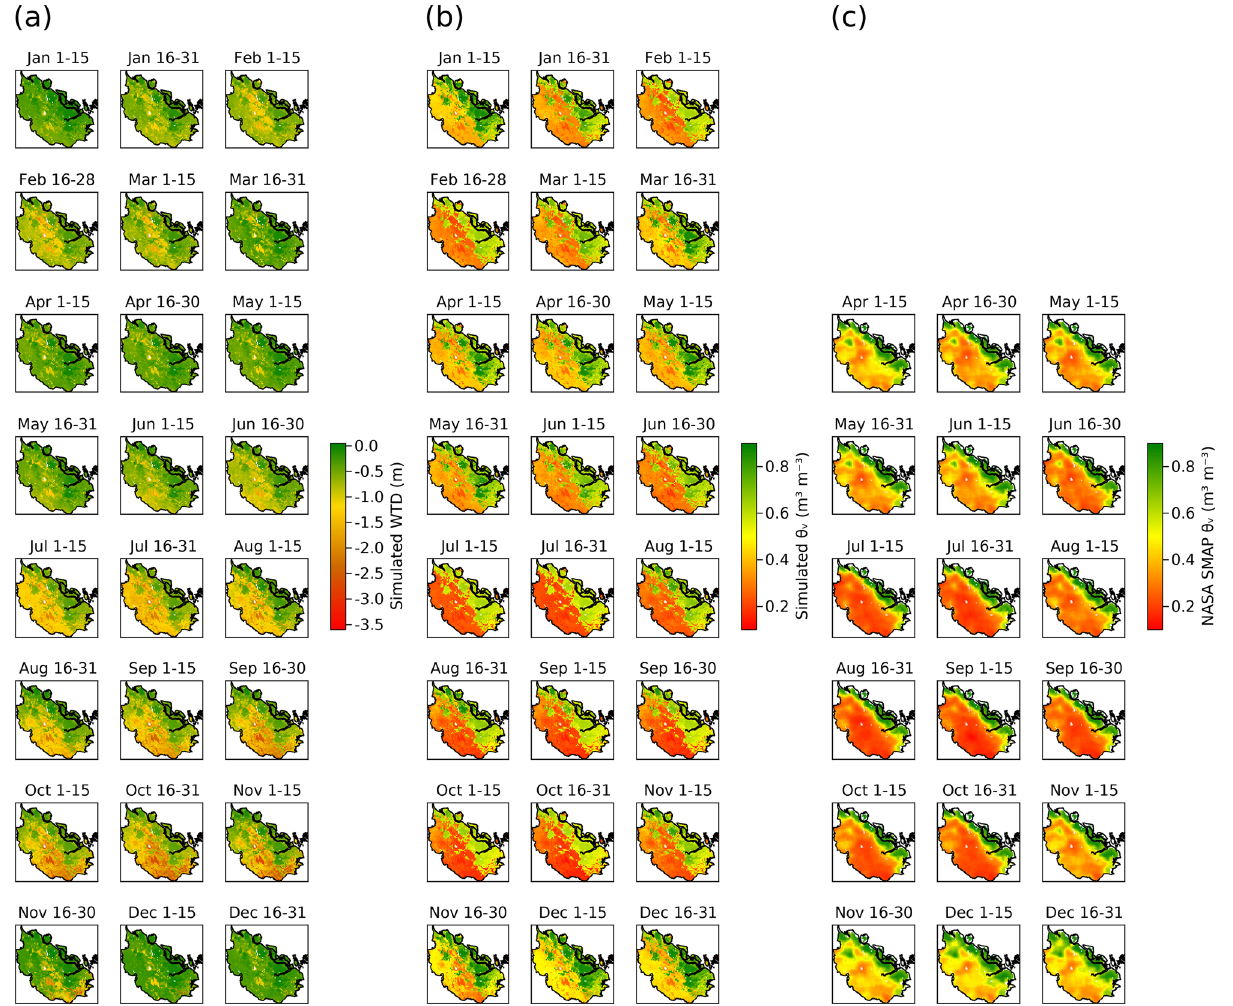
Figure 2. Spatial distribution of seasonal variations in tropical peatland and non-peatland water table depth and soil moisture contents. Half-monthly averaged ( a ) simulated water table depth (WTD) ( b ) simulated near- surface (0–0.05 m depth) soil moisture content (θ v ), ( c ) National Aeronautics and Space Administration (NASA) Soil Moisture Active Passive (SMAP) near-surface soil moisture contents during 2015 across Riau province, Sumatra, Indonesia. Negative water table depths are depths below the ground surface. The maps in ( a – c ) were created by using Julia Programming Language version 1.6.7 (https:// julia lang. org/ downl and a layer with a lower organic matter content was defined as a mineral soil. All grid-cells in which soil organic matter contents in all soil layers from surface down to 0.3 m or deeper exceeded 65% were defined as peatland grids 45 and the remaining grid-cells were defined as non-peatland grids. 2015 was a drought year with a short dry season between mid-January and late-February and a prolonged and intense dry season that lasted from mid-June to late October with a brief rainy period in early August (Supplementary Fig. S3). Beside seasonal vari- ability, modelled WTD was generally shallower and near surface soil moisture content was higher in peatland grid cells when compared to the non-peatland grid cells (Fig. 2). The near-surface peat and mineral soil mois- ture contents sensed by National Aeronautics and Space Administration (NASA) Soil Moisture Active Passive (SMAP) also showed similar seasonal and spatial variations across Riau during 2015 (Fig. 2). The seasonal vari- ation in simulated near-surface peat and mineral soil moisture contents was strongly correlated with SMAP peat and mineral soil moisture in most of the grids as indicated by a median correlation coefficient of 0.7 between daily modelled and SMAP soil moisture contents across Riau (Fig. 2) (Supplementary Fig. S4). However, mod- elled daily mineral soil moisture contents across non-peatland grids showed stronger correlations with SMAP than did modelled daily moisture contents in peatland grid cells i.e., median correlation coefficient between daily modelled and SMAP soil moisture contents was 0.56 for peatland grid cells vs. 0.79 for non-peatland grid cells across Riau (Fig. 2) (Supplementary Fig. S4). Near zero or even negative correlations in modelled vs. SMAP peat moisture contents occurred in about 25% of the peatland grids along the eastern coast of the province (Fig. 2) (Supplementary Fig. S4). Like modelled soil moisture contents, SMAP soil moisture contents were also generally higher in peatland than in non-peatland grid-cells (Fig. 3). Seasonal variations in WTD across both peatland and non-peatland grids followed the same trends in modelled and SMAP soil moisture contents (Fig. 3). Aver-